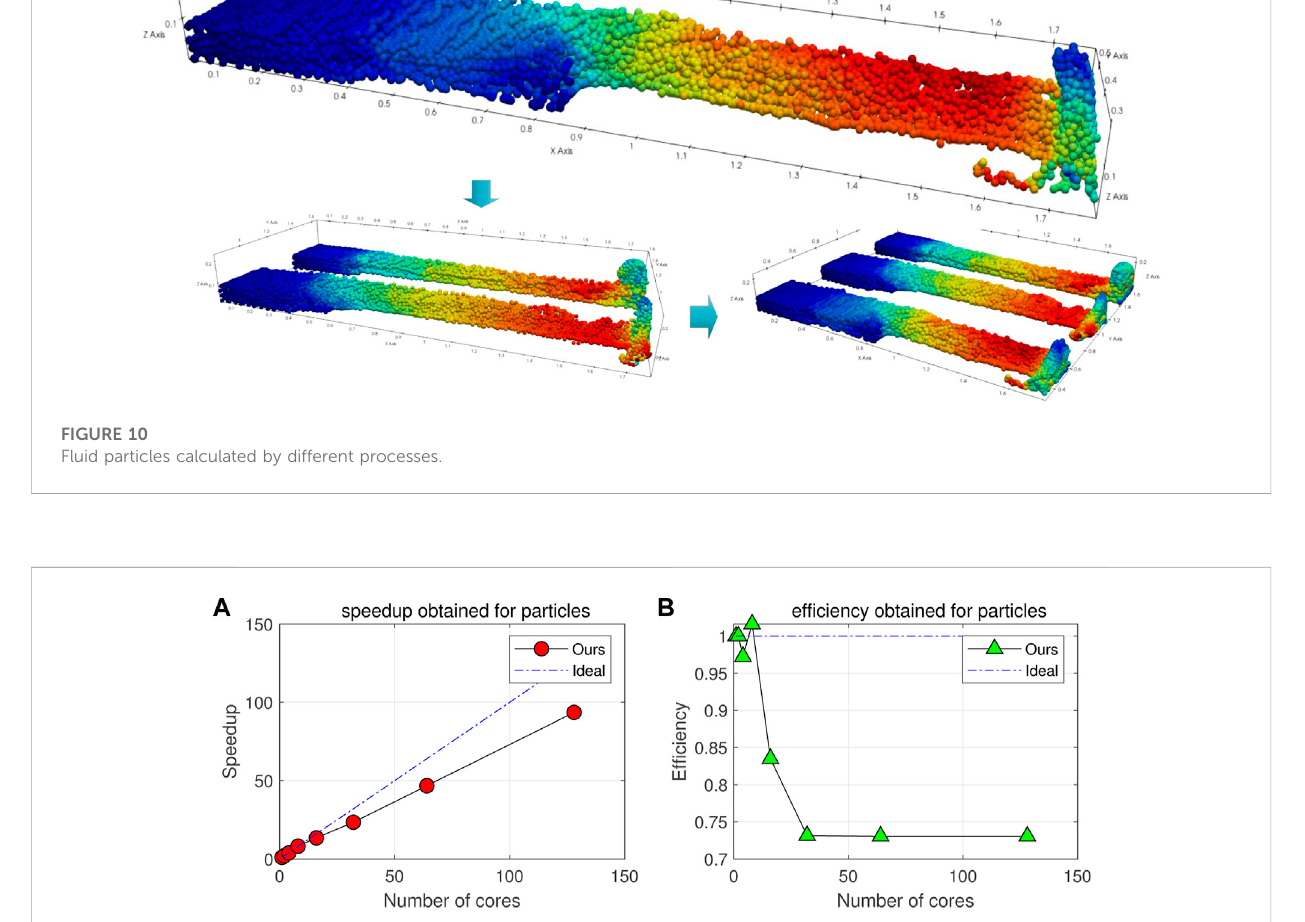
FIGURE 11 (A,B) respectivelydescribetheaccelerationandcomputationalef fi ciencyobtainedindifferentprocessesfor128Gmemorynodeswith fi xedparticle number, and it also increases the benchmark under ideal conditions for